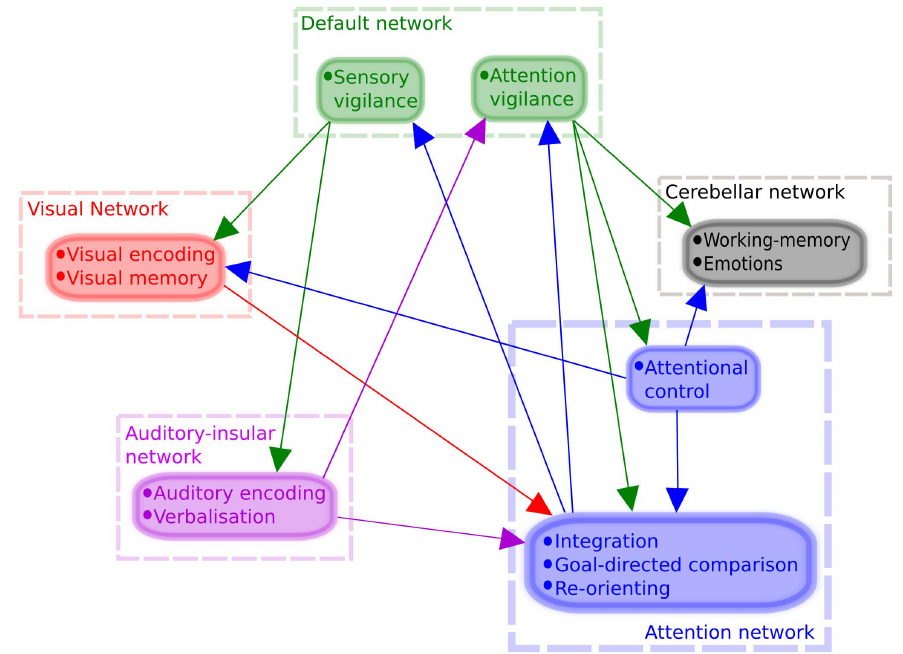
Figure 2. Proposed model for visual memory encoding based on results obtained in Figure 1. A precise description of the model is provided in the Discussion section.